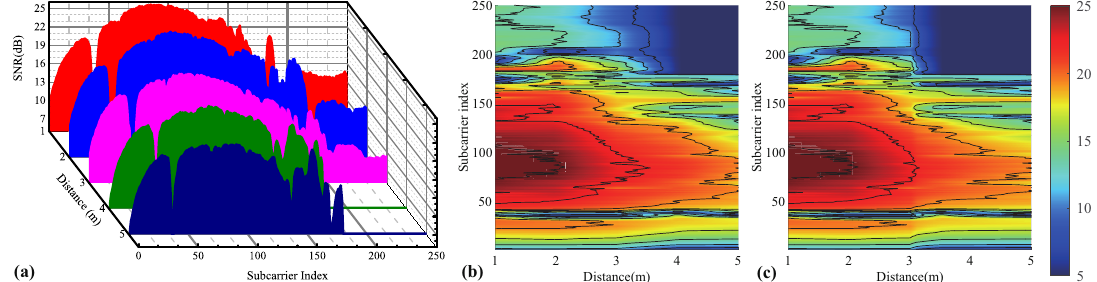
Figure 6. The measured SNR ( a ) at the calibration points and the SNR table interpolated with a ( b ) linear method and a ( c ) partially nonlinear